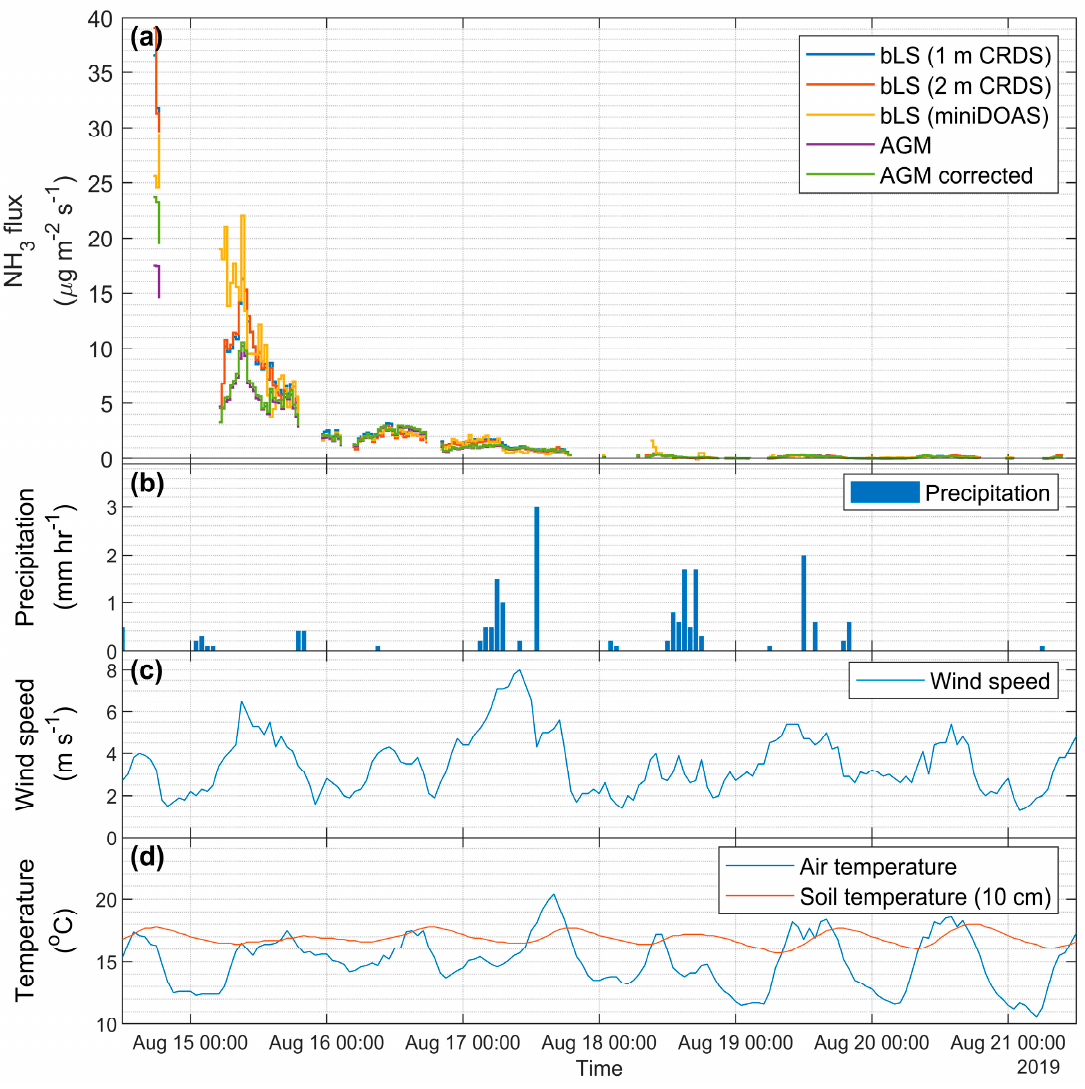
Figure 4. ( a ) Source emission of NH 3 from the measurement campaign in August presented for bLS (1-m CRDS), bLS (2-m CRDS), bLS (miniDOAS), the AGM, and the AGM with footprint correction. ( b ) Precipitation per hour, ( c ) wind speed at 10 m, and ( d ) air temperature and soil tem- perature at 10 cm. Data in ( b – d ) are recorded 5 km NE of the field. Table 2. Mean emissions of the measurement campaigns in May and August in µg m − 2 s − 1 for fil- tered data over the measurement period. AGM: aerodynamic gradient method, bLS: backward Lagrangian stochastic, CRDS: cavity ring-down spectroscopy, and miniDOAS: differential optical absorption spectroscopy.